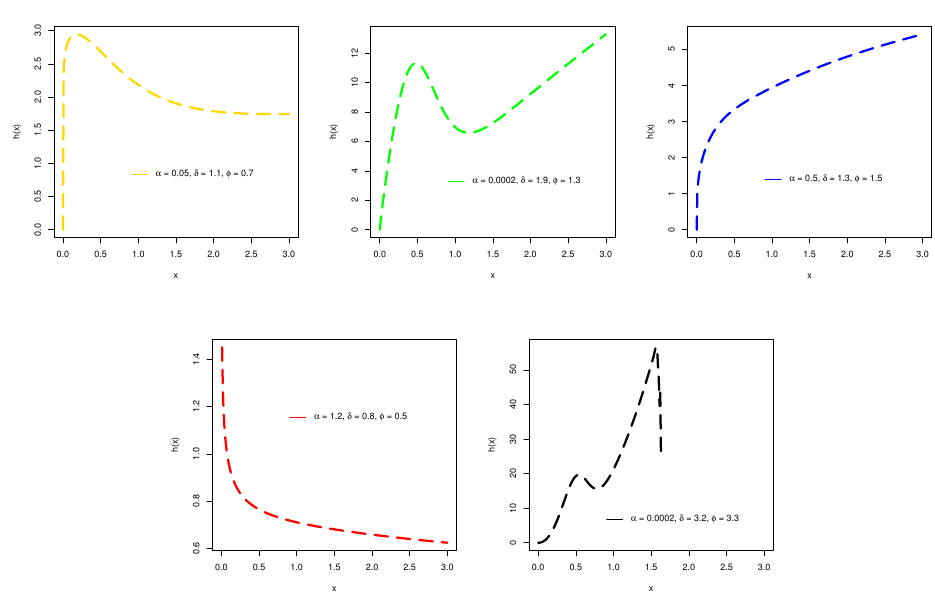
Figure 2. Illustrations of h ( x ; α , ψψψ ) of the NACos-Weibull for different values of α , φ , and δ